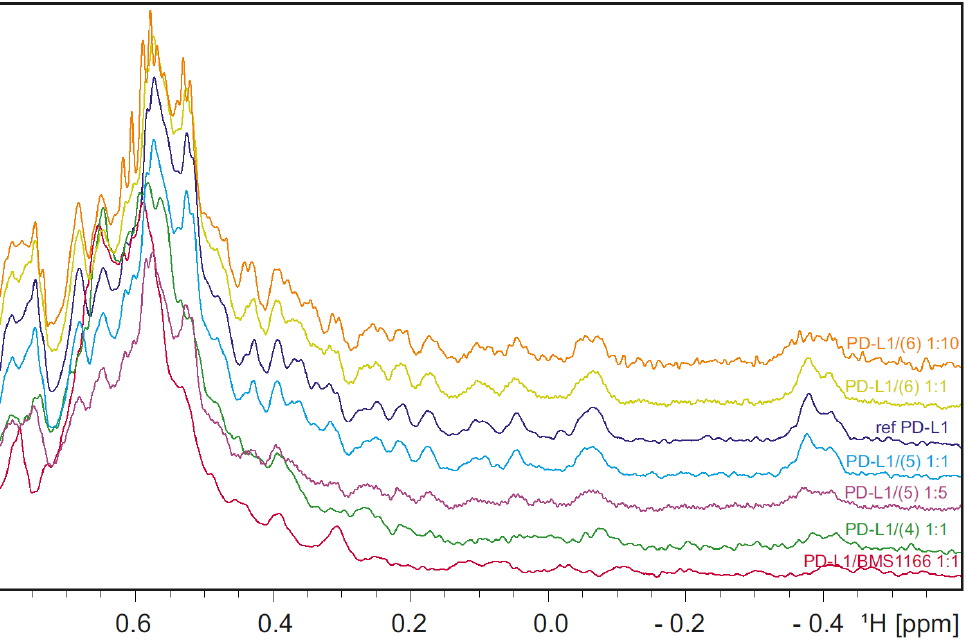
Figure 1. The aliphatic 1 H NMR spectrum of the reference PD-L1 (blue) superimposed on the spectrum of the PD-L1 titrated with compounds 4 (green—protein–ligand molar ratio, 1:1), 5 (light blue—protein–ligand molar ratio, 1:1; purple—protein–ligand molar ratio, 1:5), 6 (yellow—protein– ligand molar ratio, 1:1; orange—protein–ligand molar ratio, 1:10), and the spectrum of PD-L1 titrated with a known PD-L1 inhibitor—BMS-1166 (red, protein–ligand molar ratio, 1:1).